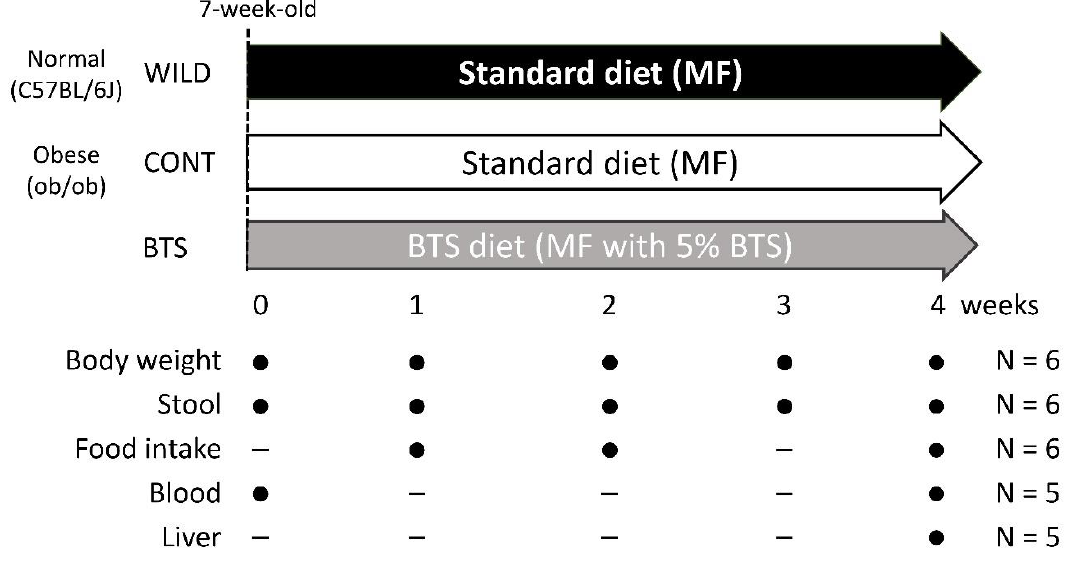
Figure 1. Study Figure 1. Study design.